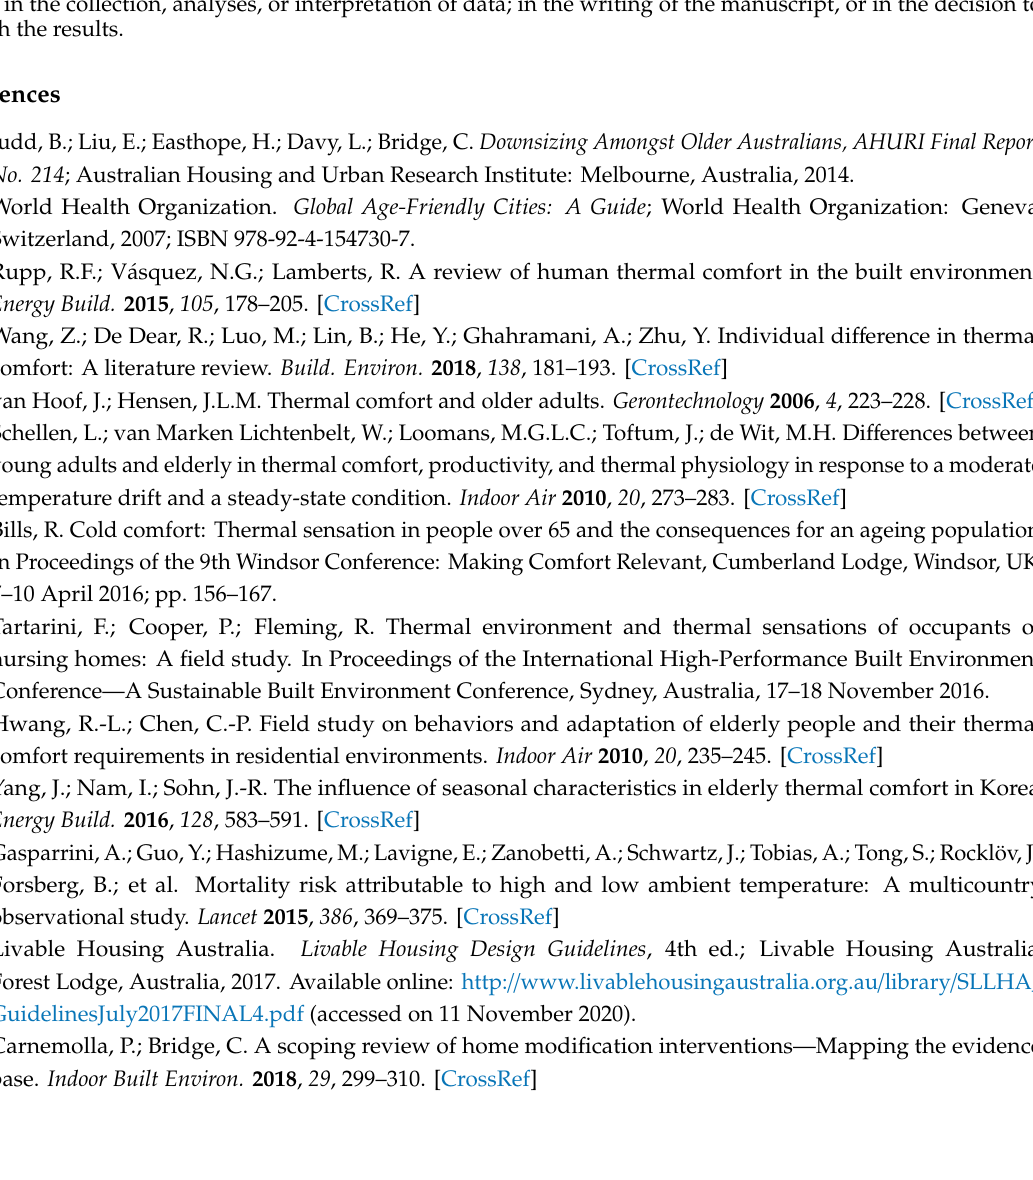
Table S1. Results of cluster